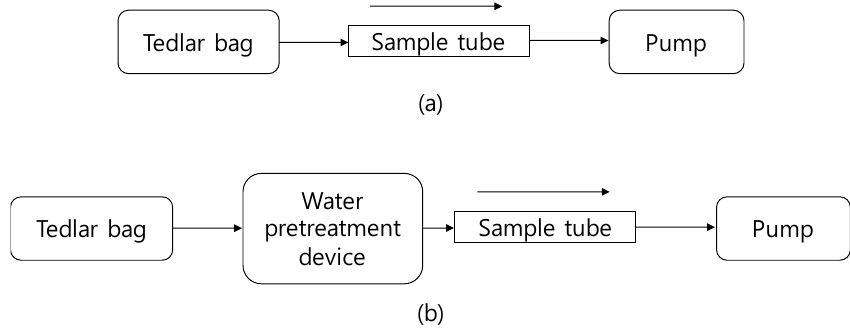
Figure 1. Sampling train for the comparison of the target chemical recovery rate: ( a ) Without water pretreatment device; ( b ) with water pretreatment device.